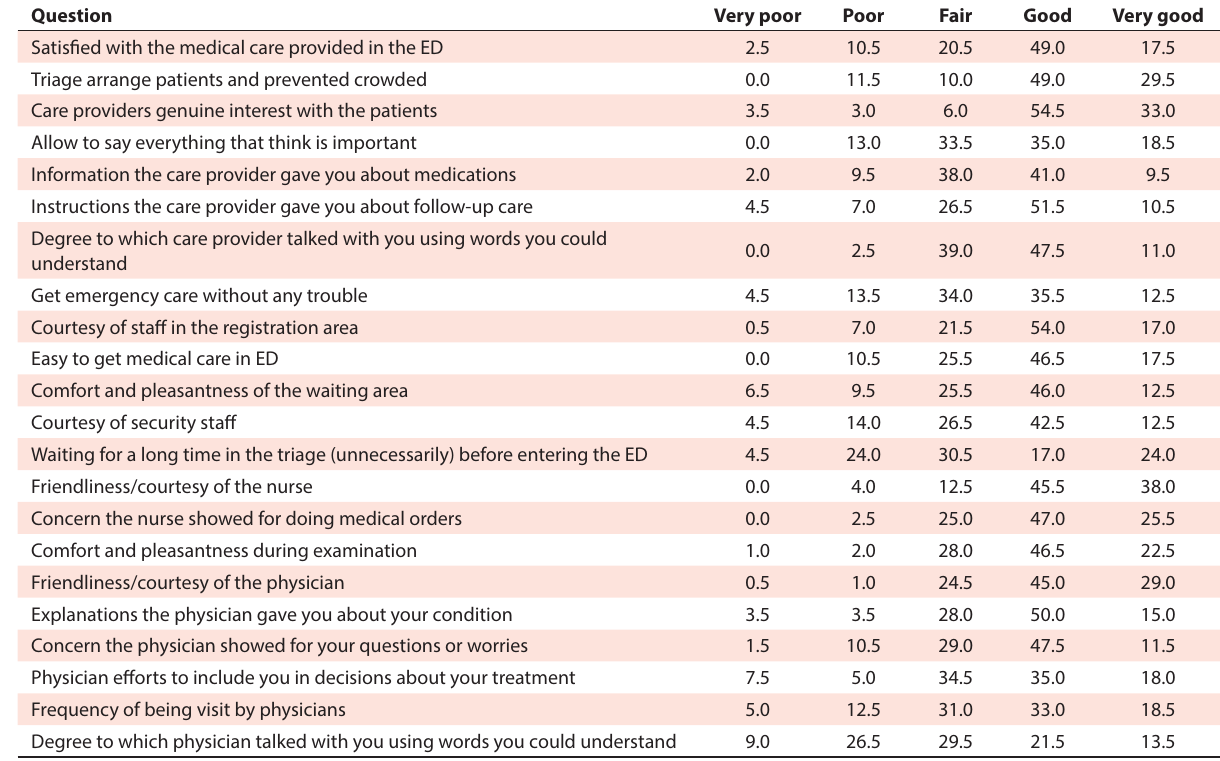
Table 2. Satisfaction level of clients in regard to 22 items of the questionnaire